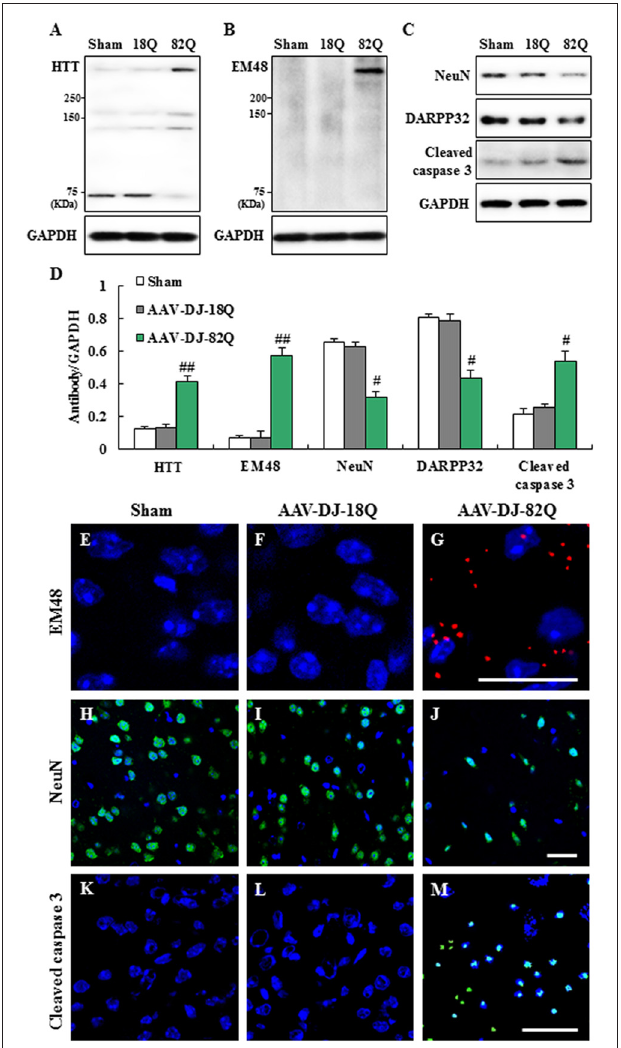
FIGURE 2 | AAV-DJ-82Q injection enhances mutant huntingtin (HTT) expression and induces neurodegeneration in the striatum. (A–E) Eight weeks after AAV-DJ-82Q-injection, the striata from sham, AAV-DJ-18Q, and AAV-DJ-82Q groups ( n = 7 per group) were analyzed by Western blot to investigate change in protein expression of HTT (clone, 2Q75 and EM48), NeuN, DARPP32 and cleaved caspase-3 (A–C) and then quantified concerning the ratio of protein to total GAPDH for each sample (D) . (A–C) show a representative Western blot. ANOVA test; # p < 0.05 and ## p < 0.01 vs. sham and AAV-DJ-18Q groups. (E–M) Striatal sections ( n = 2 per brain) from each group ( n = 7 per group) were accomplished by immunofluorescence stain using anti- HTT (clone, EM48, red) (E–G) , NenN (green) (H–J) , and cleaved caspase-3 (green) (K–M) antibodies. Scale bar denotes 100 µ